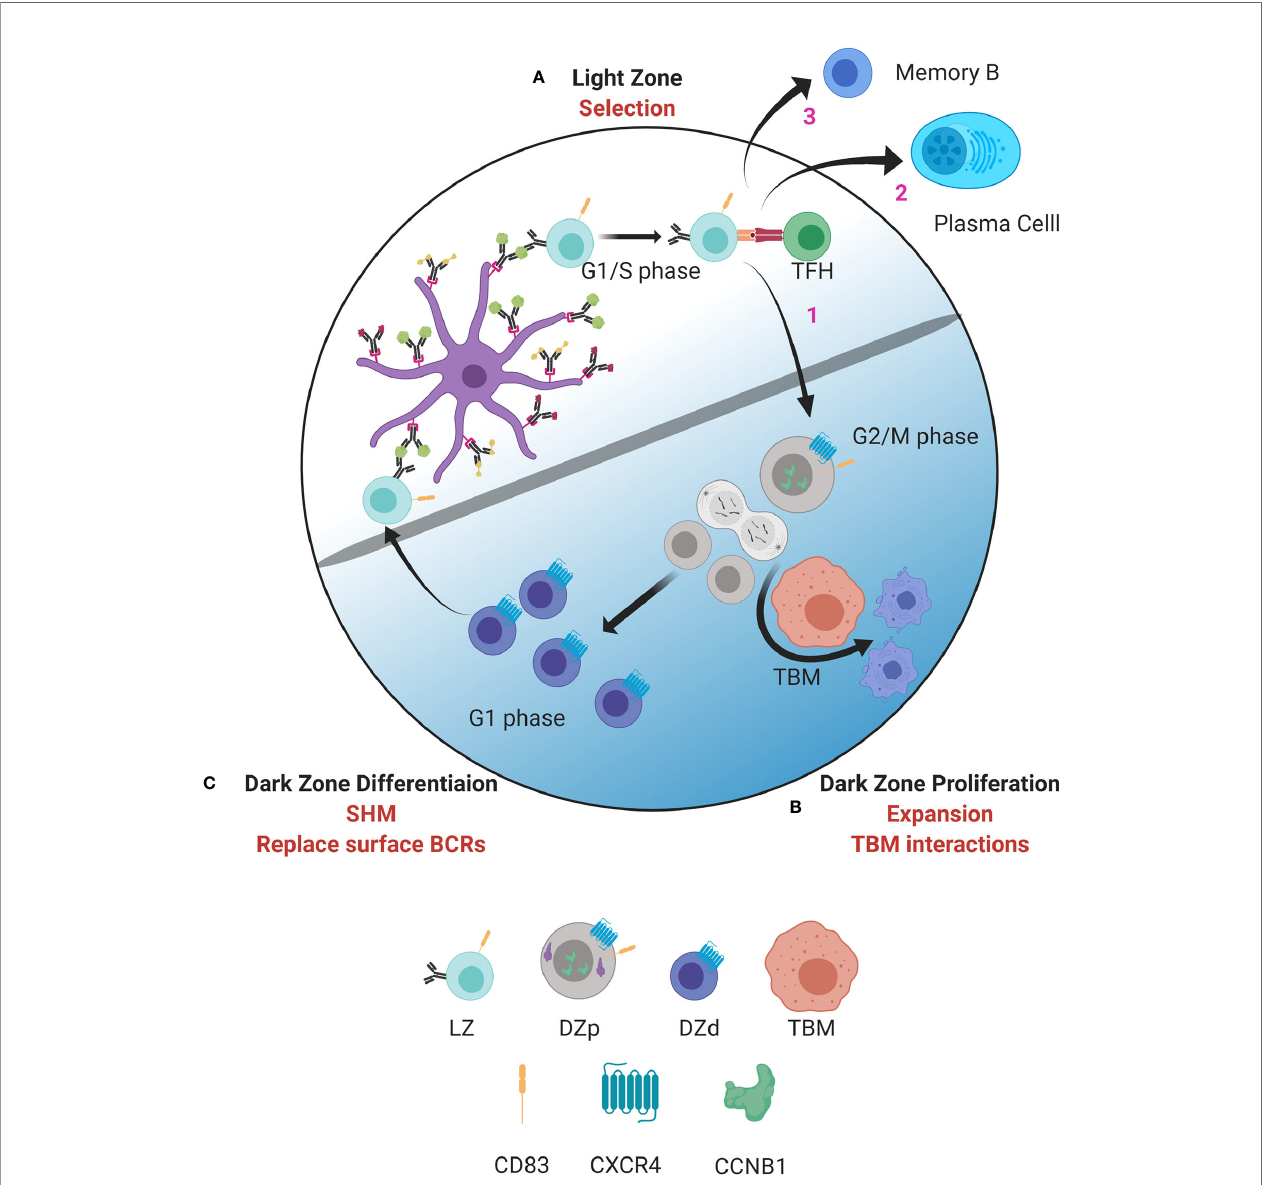
FIGURE 1 | Model of germinal center dynamics and compartmentalization. GC B cells progress through a series of molecular states compartmentalizing key functions to distinct spatial niches. (A) GC B cell selection occurs in the LZ. B cells entering the LZ from the DZd fi rst attempt to capture antigen deposited on follicular dendritic cells (FDC). This is followed by antigen processing and presentation to T FH cells in the context of MHC class II. Interactions between LZ B cells and T FH determine if B cells are fated to differentiate into MBCs or PBs, undergo cyclic re-entry into the DZp, or initiate apoptosis. Cells selected for cyclic re-entry migrate to the DZp (B) . We propose that B cells that initiate apoptosis in the LZ are cleared by TBMs in the DZp niche. Those cells that are successfully selected in the LZ, and therefore are not cleared by TBMs, undergo mitosis. (C) After one or more rounds of cell division, GC B cells transit to the DZd compartment where differentiative functions, such as SHM and replacing old BCRs with newly mutated BCRs, are proposed to occur. B cells that successfully complete processes in the DZd migrate to the LZ to undergo selection. Figure created with